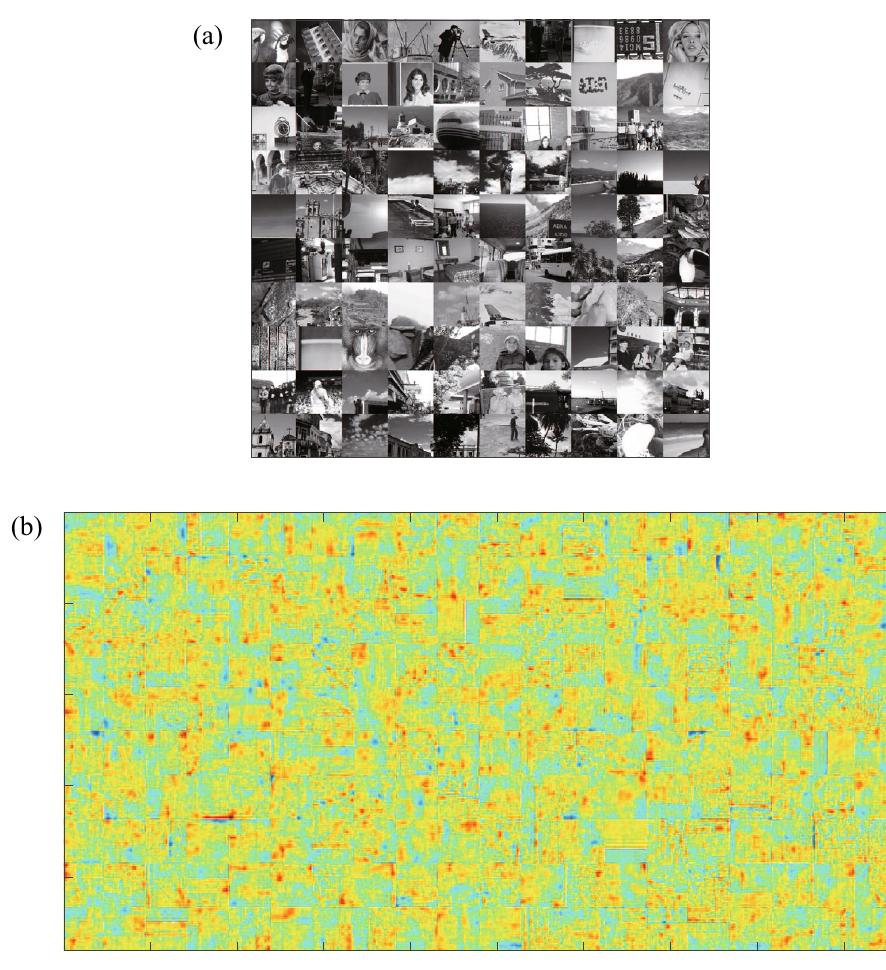
Figure 7. Dictionary trained by using the standard image datasets 41,42 : ( a ) images included in the standard image dataset and ( b ) basis images trained by using the standard image